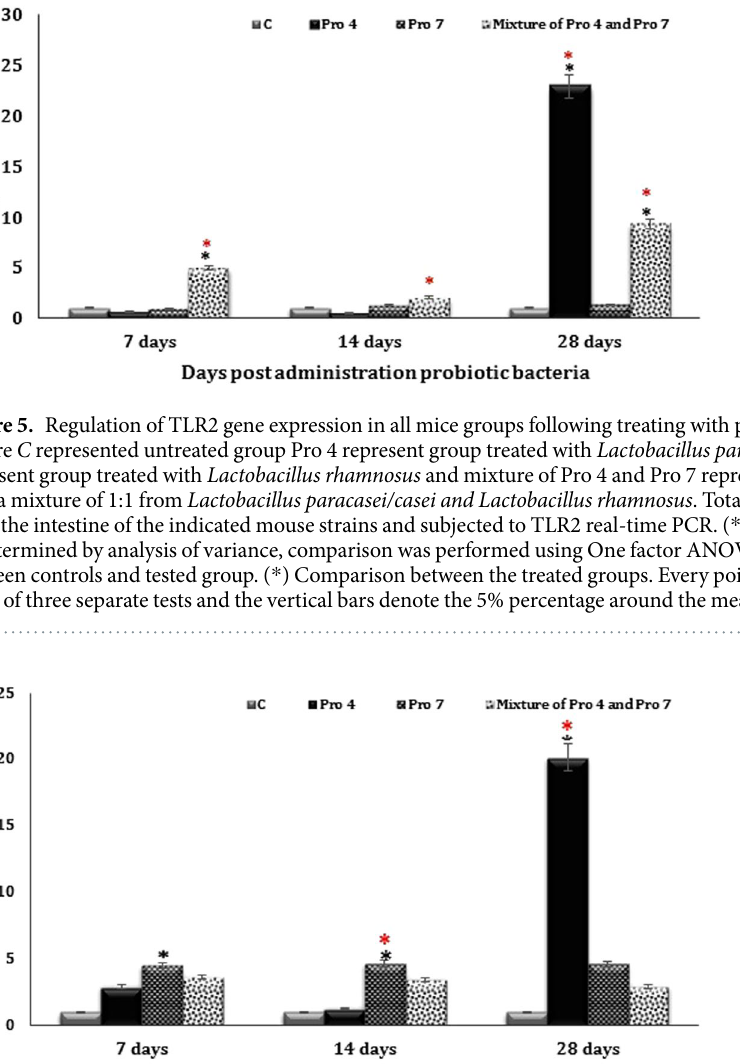
Pro 4 and Pro 7 strains respectively) compared to untreated group. Both Pro 4 and Pro 7 groups illustrated high significant increase in polyclonal IgG as compared to a mixture of Pro 4 and Pro 7 mice group ( P = 0.0000) in the same time periods. Total IgG increased significantly ( P = 0.016 and 0.004) in mice sera treated with Pro 7 strain for 14 and 28 days compared to those treated with Pro 4 strain (Fig. 7a). The current probiotic strains Pro 4, Pro 7 and their mixture increased significantly the circulating total IgM in the mice sera compared to the C group ( P = 0.000) ( P = 0.031, 0.04, and 0.025) after 7 days as well as 14 days respectively. Blood sera collected from all treated mice groups post 28 days’ exposure to the current strains seemed more similar to untreated control group (Fig. 7b). Evaluating analysis of the total IgM levels produced post administration of the three current probiotic strains- showed a significant increase in mice obtained Pro 4 strain comparing to Pro 7 and mixture of Pro 4 and Pro 7 mice groups ( P = 0.0032, and 0.0075) after 7 days from the exposure. In contrast, no significant differences were detected in the certain polyclonal Ig circulating in mice sera of Pro 4, Pro 7 and mixture of Pro 4 and Pro 7 groups after 14 and 28 days (Fig. 7b). With 7 days, polyclonal IgA circulating in mice sear exposed to Pro 4 and Pro 7 strains seemed as similar as to the C group, meanwhile